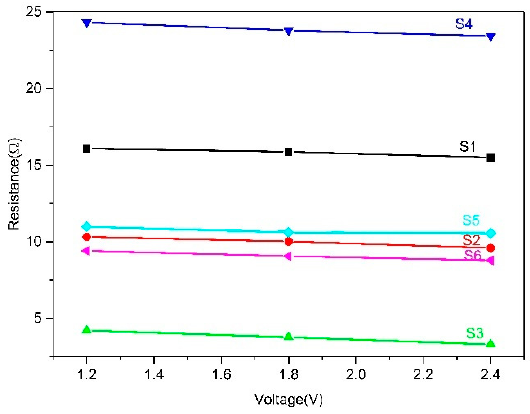
Figure 8. Sample resistance change with voltage of S1–S6 at 1.2, 1.8, and 2.4 V. Table 5. Simulated voltage and resistance equations of samples S1–S6 at 1.2, 1.8, and 2.4V. Sample No.